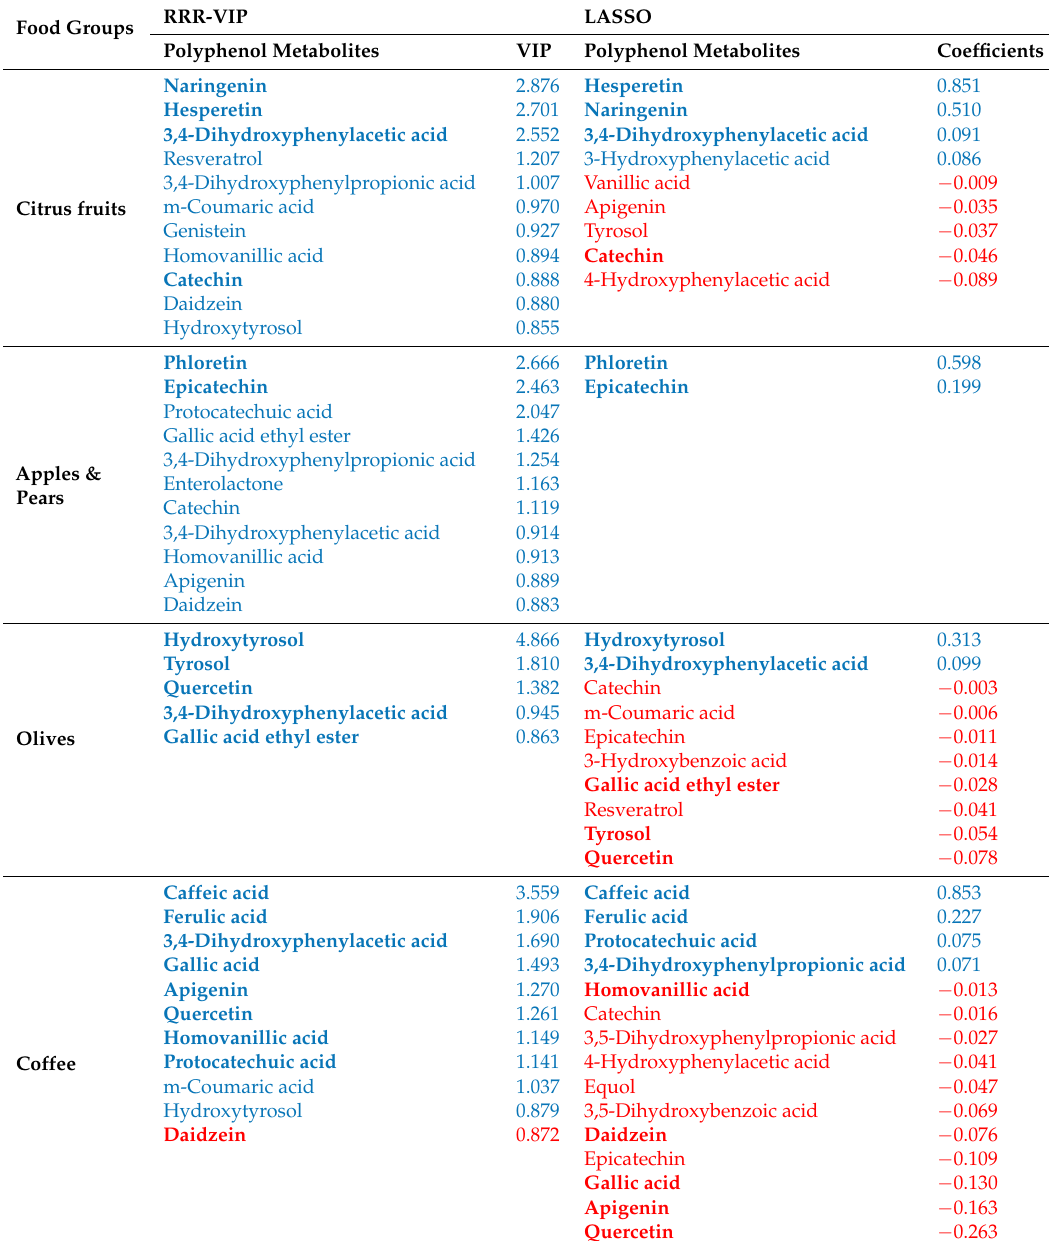
Table 3. Selected polyphenol metabolites a by reduced rank regression-based variable importance in projection (RRR-VIP) or least absolute shrinkage and selection operator (LASSO) methods ( n =